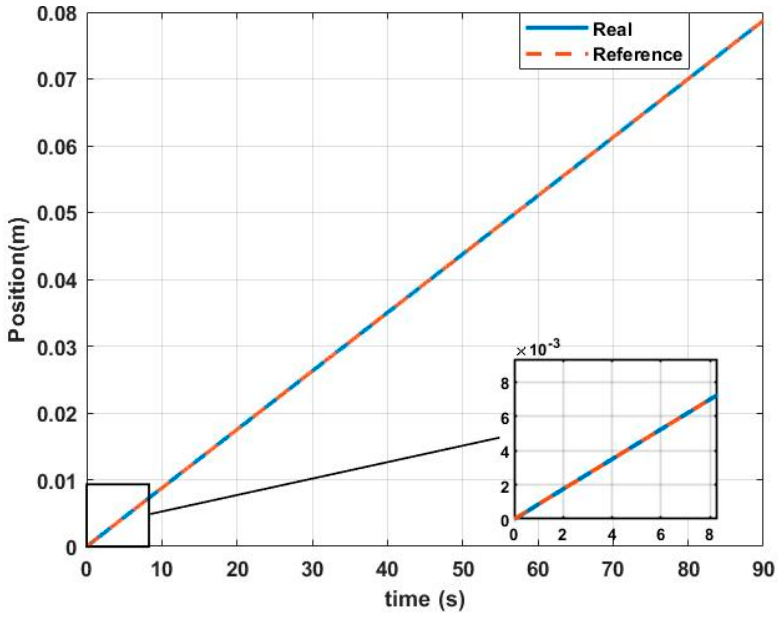
Figure 11. 𝑍 ( 𝐵𝑙𝑢𝑒 𝑆𝑜𝑙𝑖𝑑 𝑙𝑖𝑛𝑒 ) real vs. 𝑍 ( 𝑟𝑒𝑑 𝑑𝑜𝑡𝑡𝑒𝑑 𝑙𝑖𝑛𝑒 ) desired.